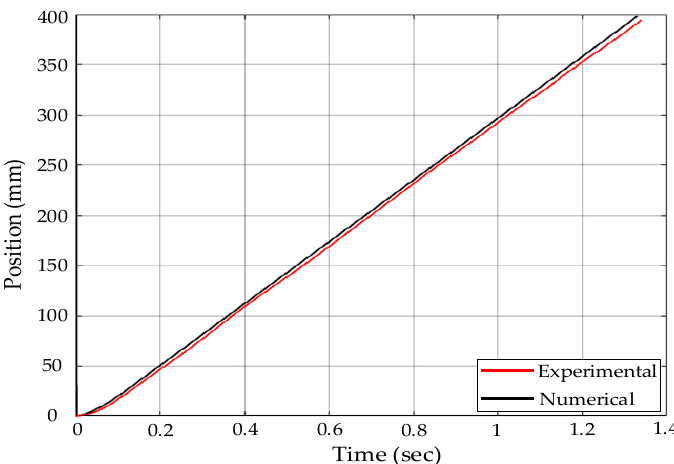
Figure 16. Total system with position measurement.